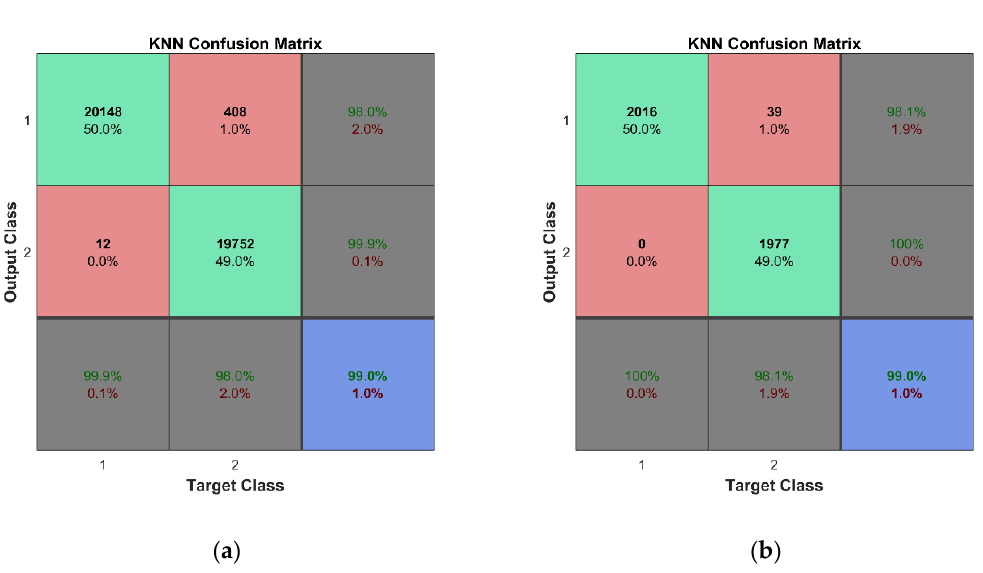
Figure 20. Classification results for the first learning scheme: ( a ) cross-validation results; ( b ) predictive performance on unseen FEM data.